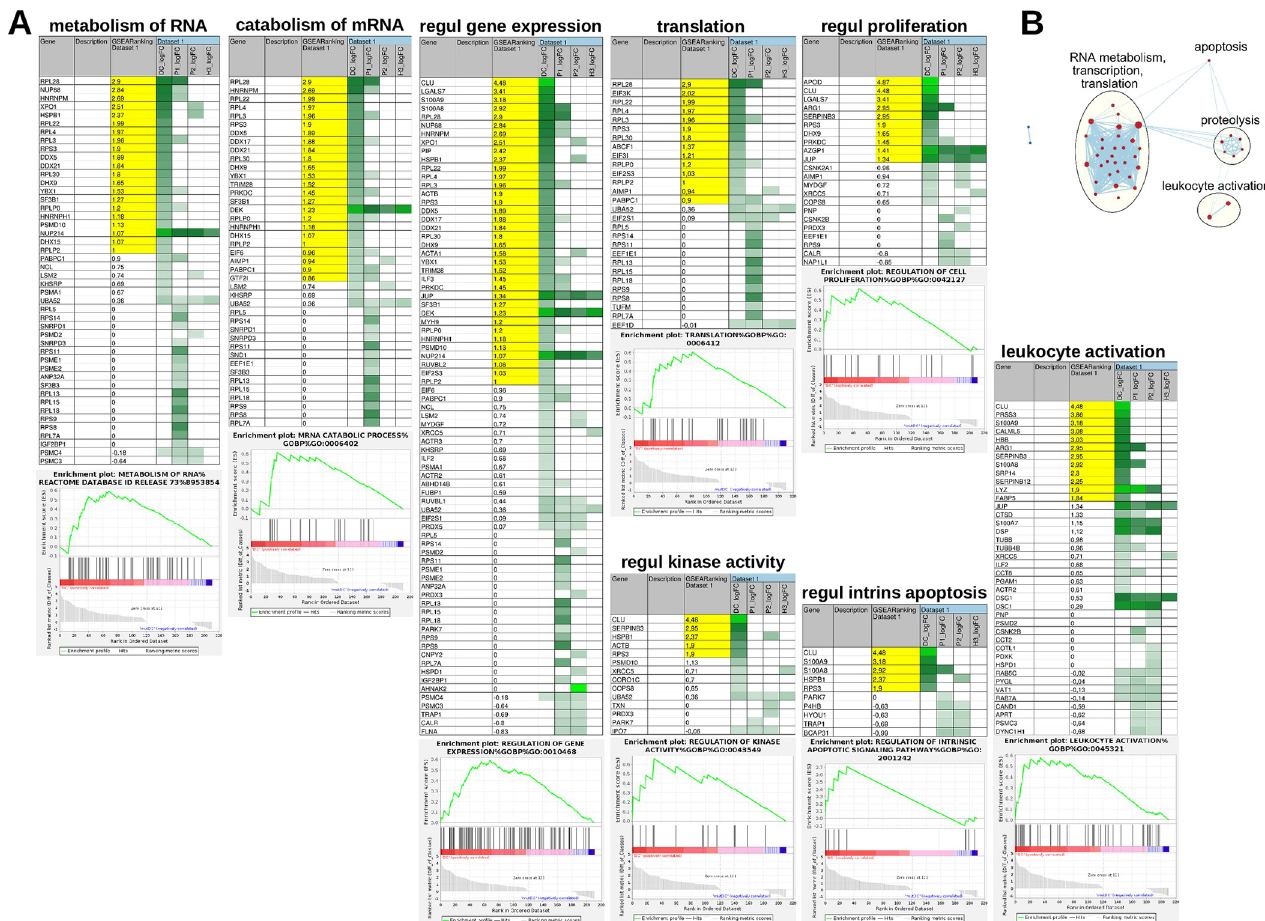
Fig 6. Bioinformatic analysis of biological processes comparing the interactome of DEK/NUP214 with those of its mutants by GSEA and Cytoscape– quantification of interactions. The filter in GSEA was set at a minimum of 10 genes/set. A. Shown are the eight most statistically significant processes revealed by GSEA. DC_logFC, P1_logFC, P2_logFC, and H3_logFC- the data set names given by GSEA to the list of interactors of DEK/NUP214, Δ P1/NUP214, Δ P2/ NUP214, and DEK/ Δ H3B, respectively. Yellow—leading-edge subset proteins responsible for the enrichment of the respective gene sets. The intensities of green correlate with the strength of interaction between DEK/NUP214, Δ P1/NUP214, Δ P2/NUP214, or DEK/ Δ H3B and the given interactors. B. The analysis of the interactomes of DEK/NUP214 and its mutants in GSEA was refined in Cytoscape/EnrichmentMap, showing the processes highly enriched in the interactome of